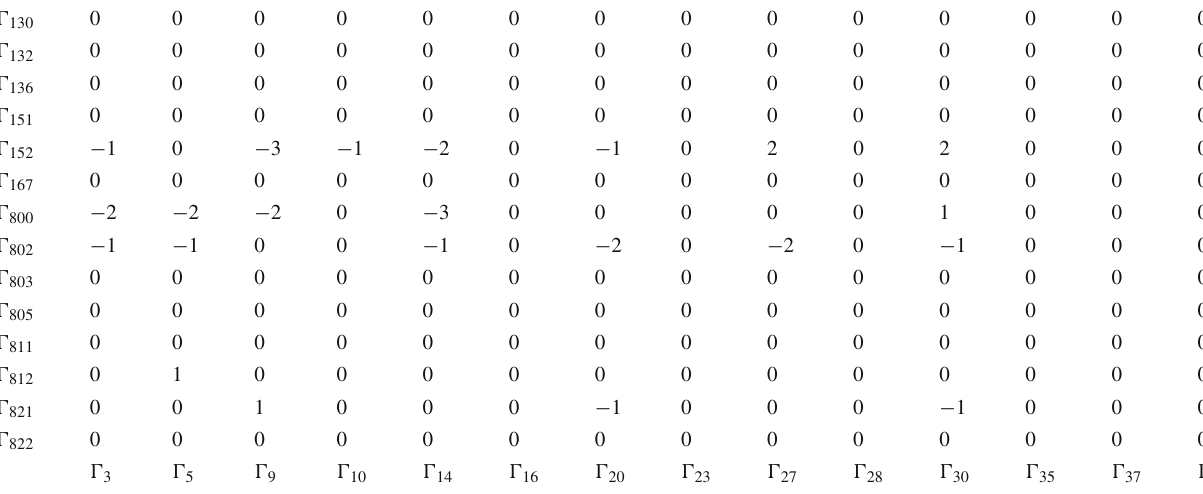
Table 307 Basis quantities correlation coefficients in percent, subtable